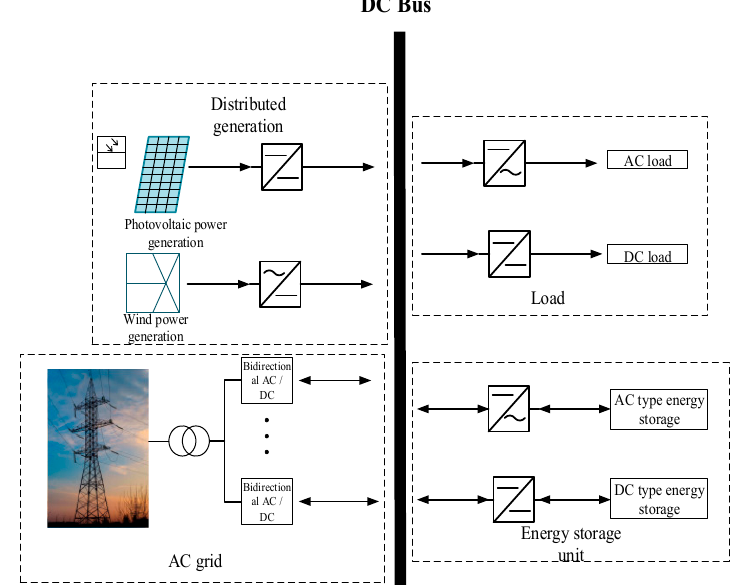
Figure 1. Typical topology of DC microgrid.